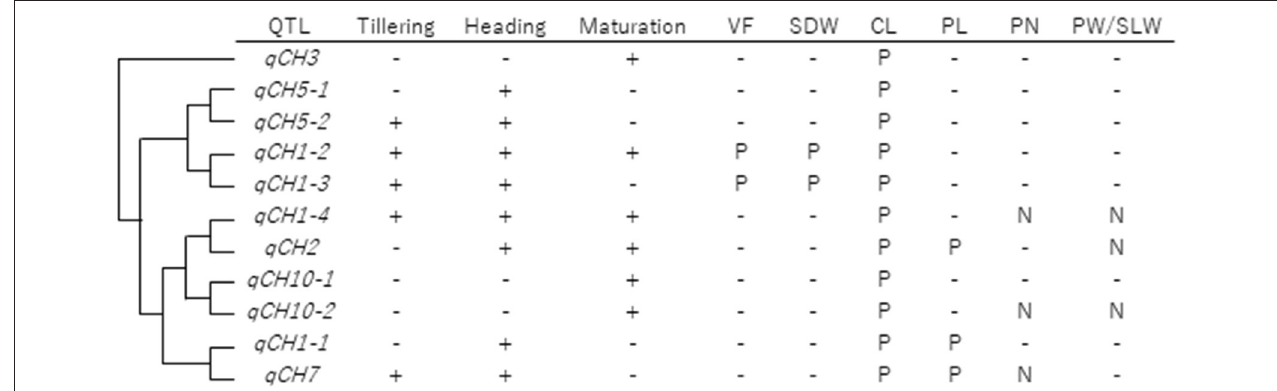
FIGURE 6 | Summary of qCH QTLs. qCH QTLs were aligned in order of hierarchical clustering in terms of haplotype effect on CH in 2019 and 2018, shown in Supplementary Figure 9 . Each QTL was detected in the three stages (tillering, heading, and maturation) and the positive (P) or negative (N) relationships of haplotype effects between CH and VF, SDW, CL, PL, PN, and PW/SLW were shown. In terms of VF and SDW, results shown in Supplementary Figure 12 were summarised. In terms of CL, PL, and PN, P or N was labelled when significant correlation ( P < 0.05) was detected a total of twice or more among the six time points in 2019 and 2018. In terms of PW/SLW, results shown in Figure 5B were